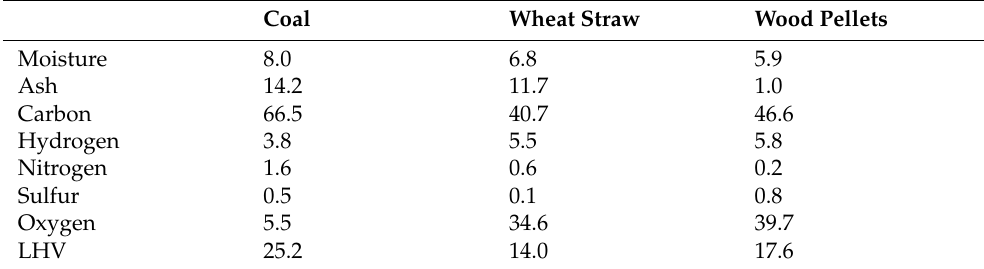
Table 2. Composition (% DM) and lower heating value (LHV, MJ/kg) of coal and biomass [31]. Coal Wheat Straw Wood Pellets Moisture